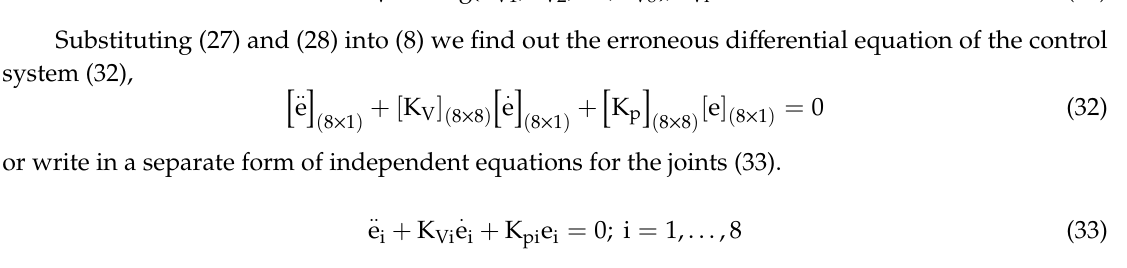
Figure 2. Representation of the cutting force model of the cutting edge i of a disk dz in milling.